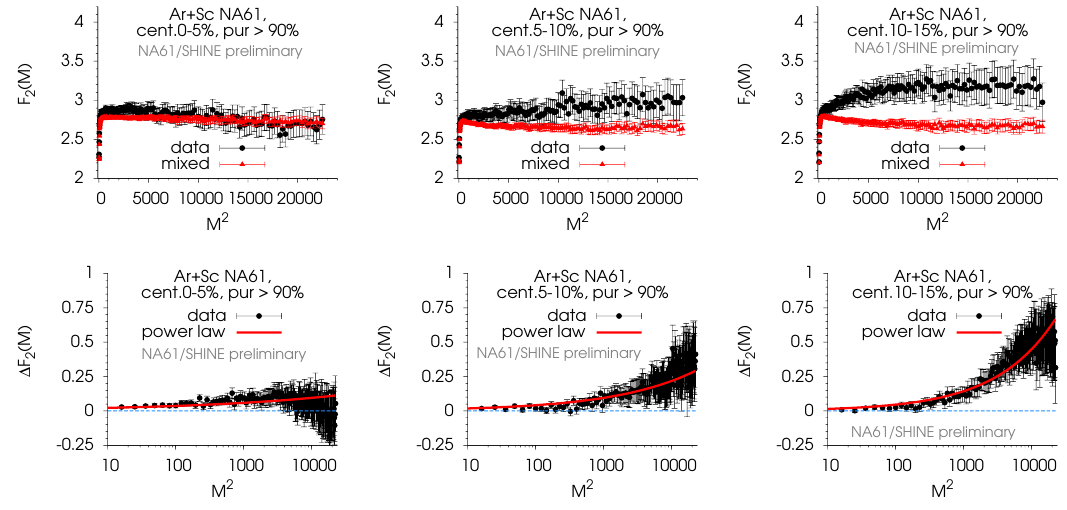
Figure 3. ( Top row ) F 2 ( M ) of original (filled circles) and mixed events (filled triangles) for NA61 Ar + Sc collisions at 0–5% (left), 5%–10% (middle), and 10%–15% (right) centrality at 150 A GeV/ c √ s NN = 16.8 GeV). ( Bottom row ) ∆ F ( to guide the eye and correspond to power-law scaling functions, ∆ F parameters: (left) φ 2 = 0.21, C = − 4.27; (middle) φ 2 = 0.36, C = − 4.84; (right) φ 2 = 0.49, C = −